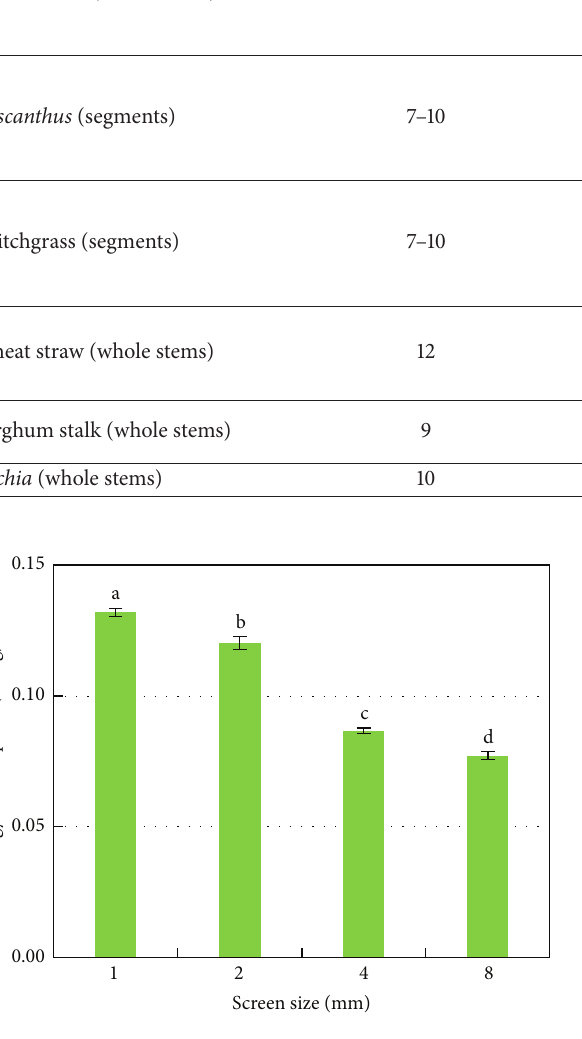
Figure 8: Effects of screen size on energy consumption in size reduction of big bluestem. Table 3: Chemical compositions (% dry weight basis) of big bluestem after